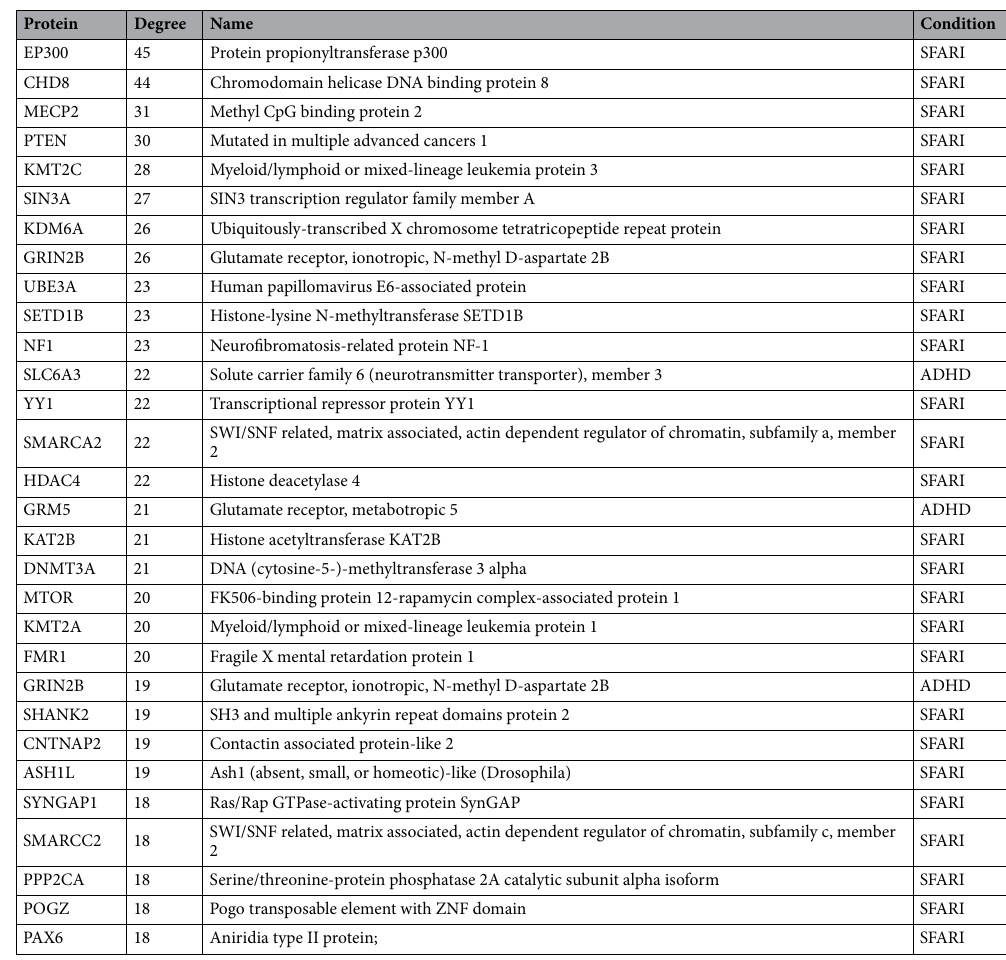
Table 1. Top 30 hub proteins, ranked by node degree, from protein–protein interaction analysis. Degrees obtained from Cytoscape and stringApp plugin. The Hub proteins shown are from ADHD and Autism SFARI datasets. (Such datasets have a statistically significant network connectivity compared to controls.) A node is designated as hub if its degree is greater than one plus the average degree of the corresponding control group. The entire list of hub proteins is in the Supplementary Information